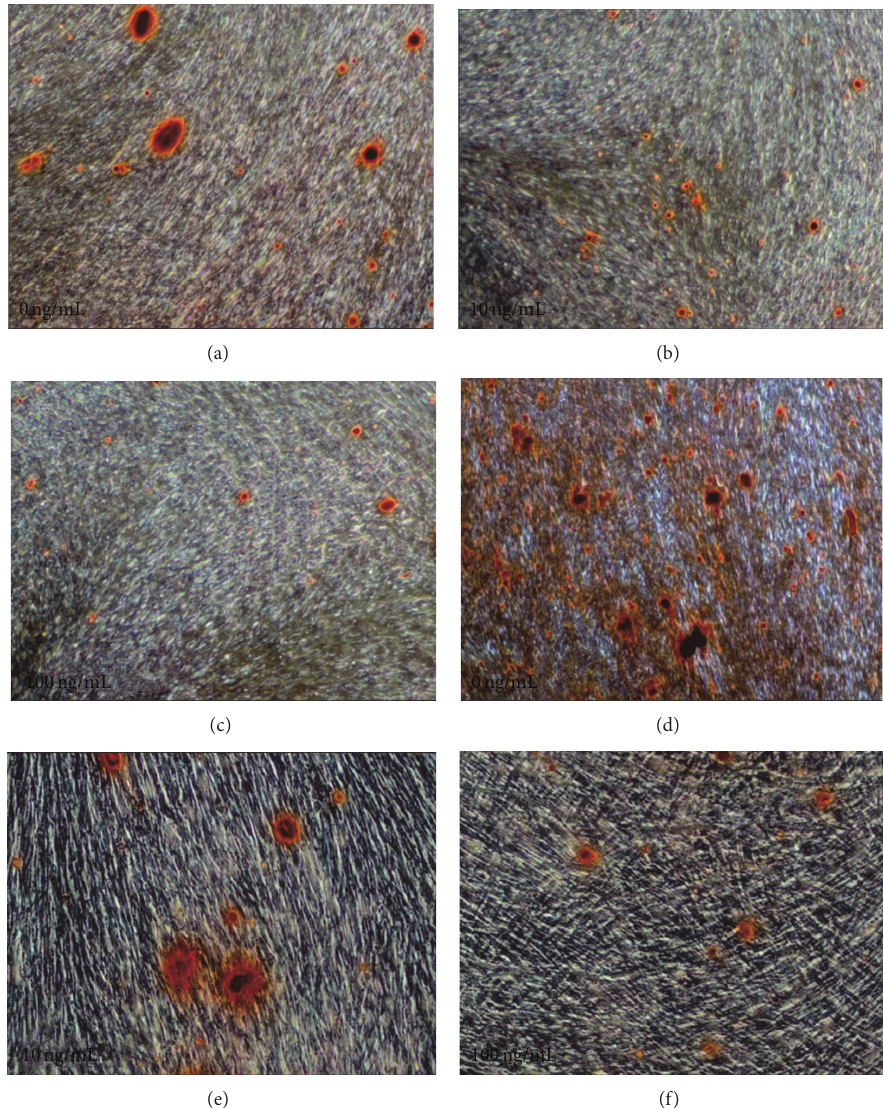
Figure 4: Alizarin Red-S staining results of mineralization in OCCM-30 and MC3T3-E1 cells with TGF- 𝛽 1 treatment.